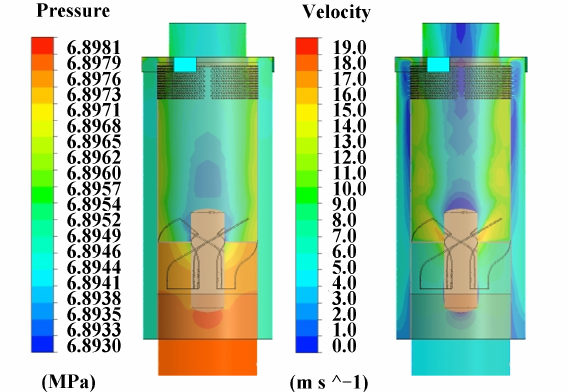
Figure 8. Pressure and velocity magnitude distribution of the reference model.